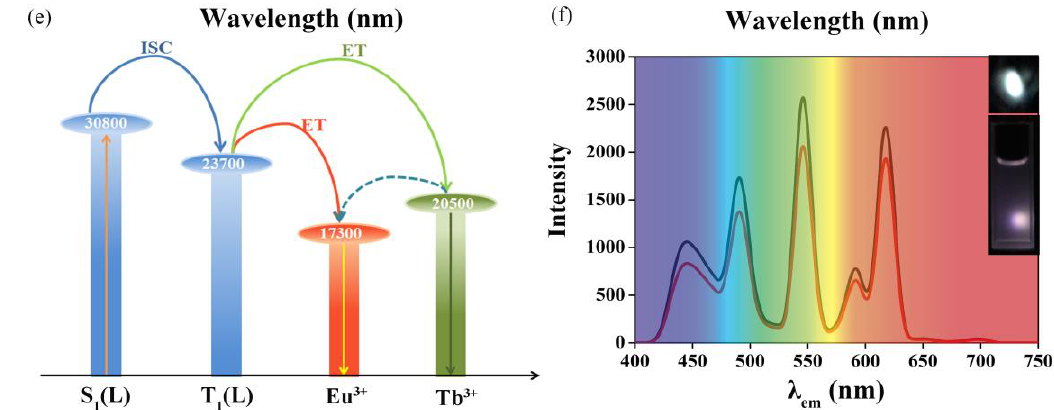
Figure 2. Solid-state photoluminescent spectra of ( a ) H 3 dcpcpt, ( b ) 1 , ( c ) 2 , and ( d ) 3 . ( e ) Simplified schematic diagram of energy transfer process. ( f ) Luminescent spectra and optical photographs of complex 4 in solid state and well-dispersed 0.01 M aqueous solution under the excitation of 320 nm.